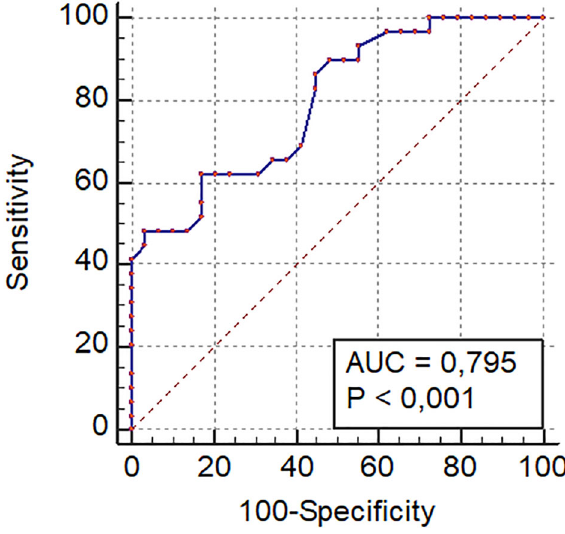
Figure 3. Curve receiver operating characteristic (ROC) of left ventricular strain.